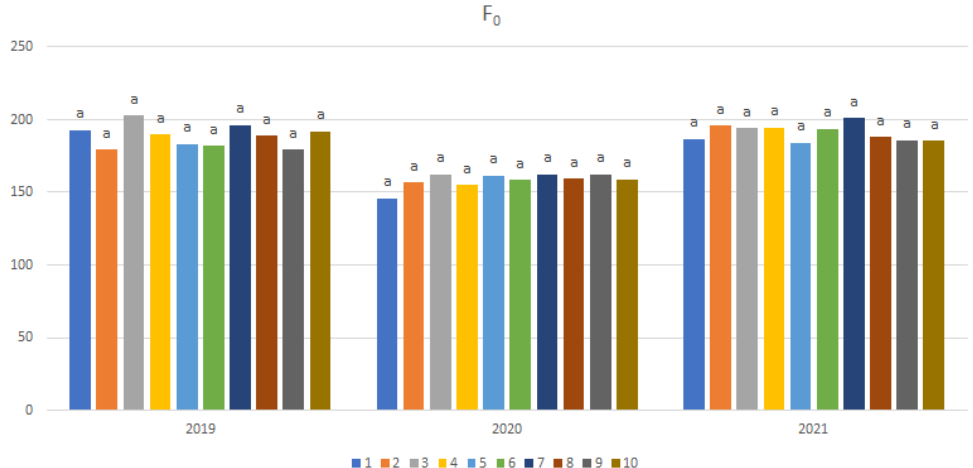
Figure 2. F 0 (minimum fluorescence) results for maize in individual years of research. Different letters indicate statistically different mean LSD (0.05): 2019 = 18.98; 2020 = 11.27; 2021 = 15.63. The combination numbers are as specified in Tables 5 and 6.